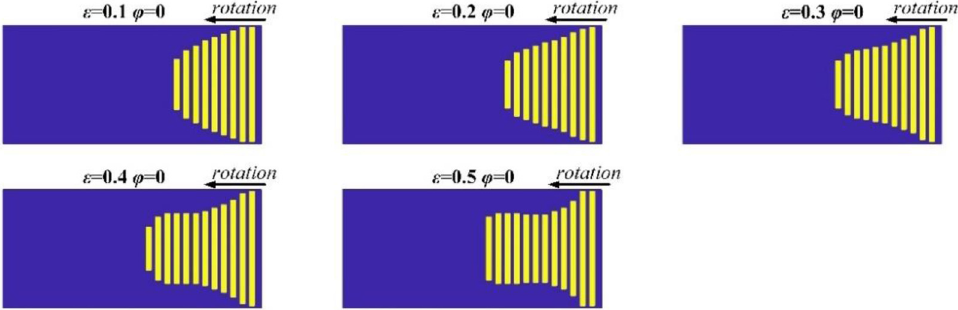
Fig. 10. The optimal groove textures under e =0.1 – 0.5, ’ = 0, N = 2000rpm.